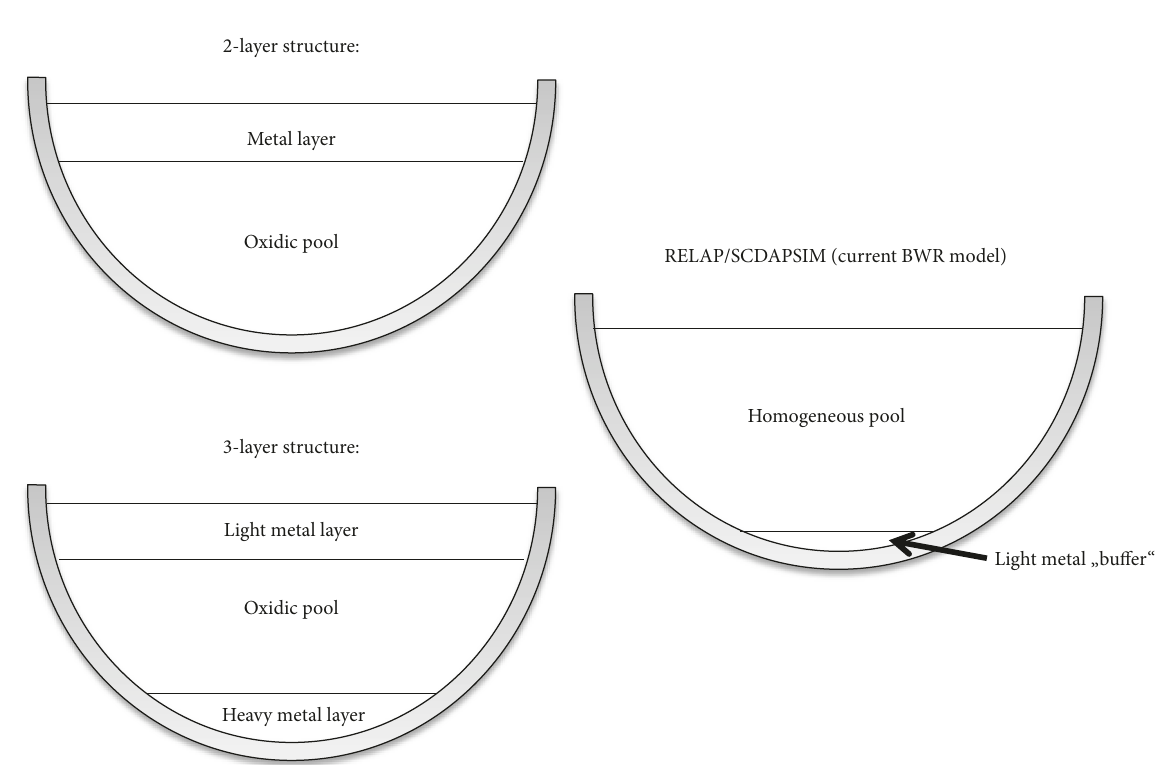
Figure 9: Layer formation in debris bed compared to RELAP/SCDAPSIM